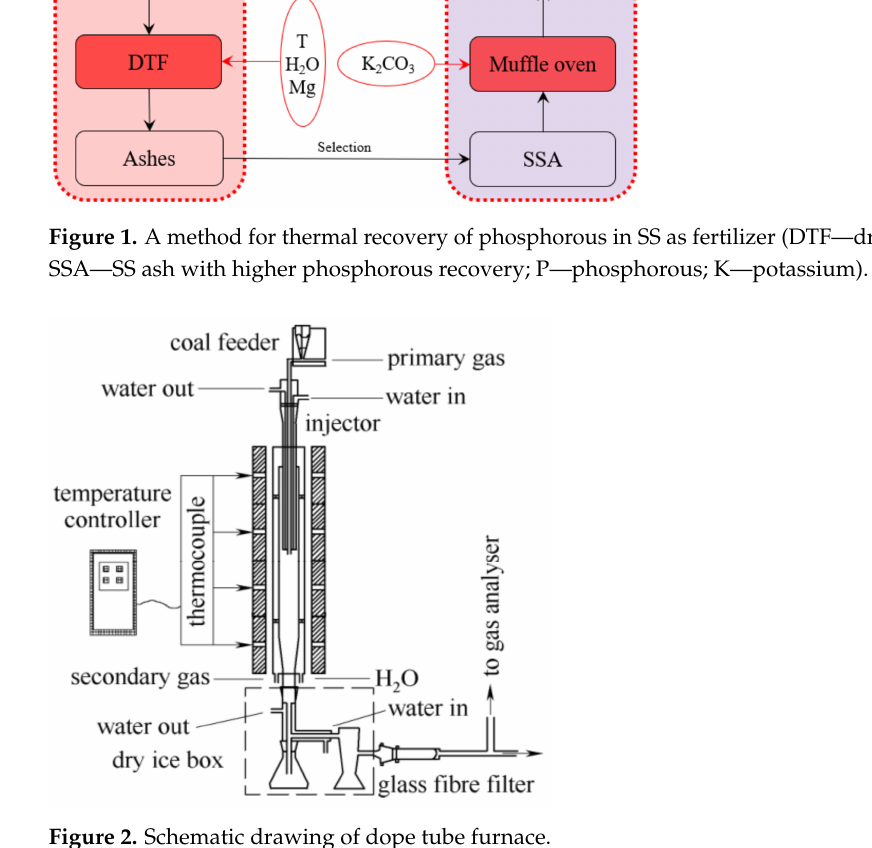
Figure 2. Schematic drawing of dope tube